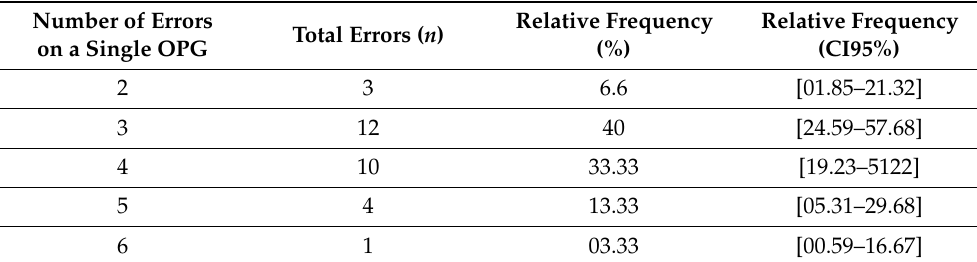
Table 1. The number of errors on a single image.